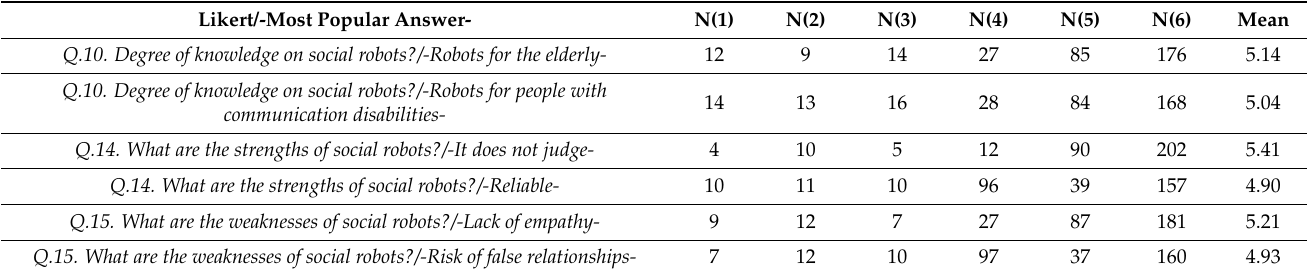
Table 3. Results related to the two most popular answers of each Likert with the details of the assessment. Likert/-Most Popular Answer-